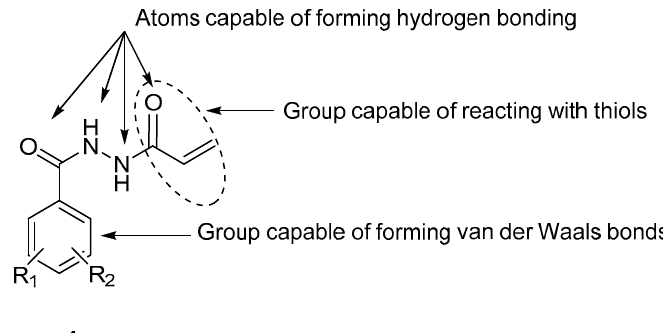
Figure 1. Atoms and groups in series 1 which are capable of bonding with cellular constituents.